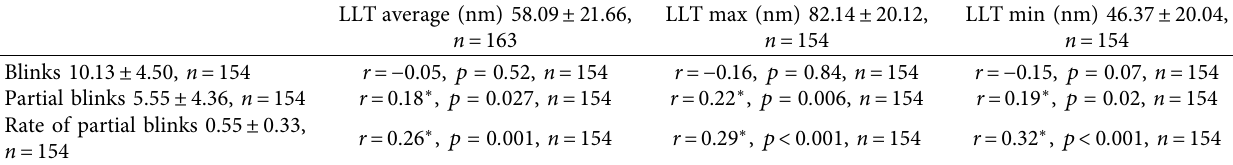
Table 1: LLT (average, minimal, and max) and blinking pattern of 163 eyes at baseline.